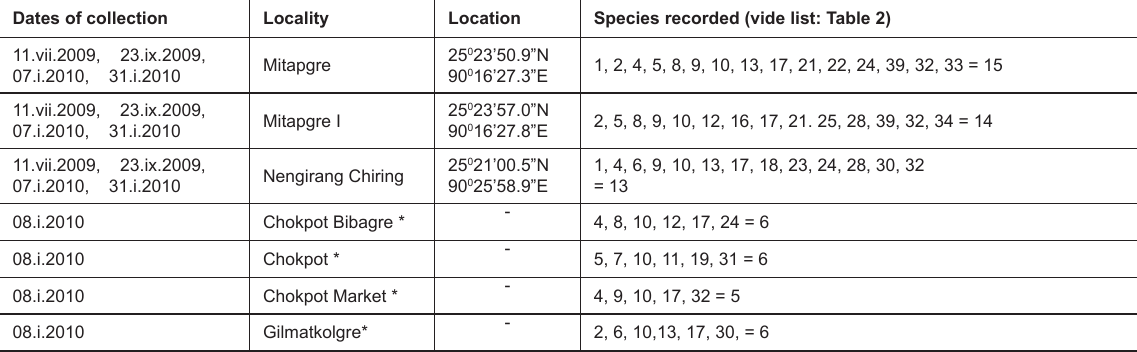
Dates of collection Locality Location Species recorded (vide list: Table